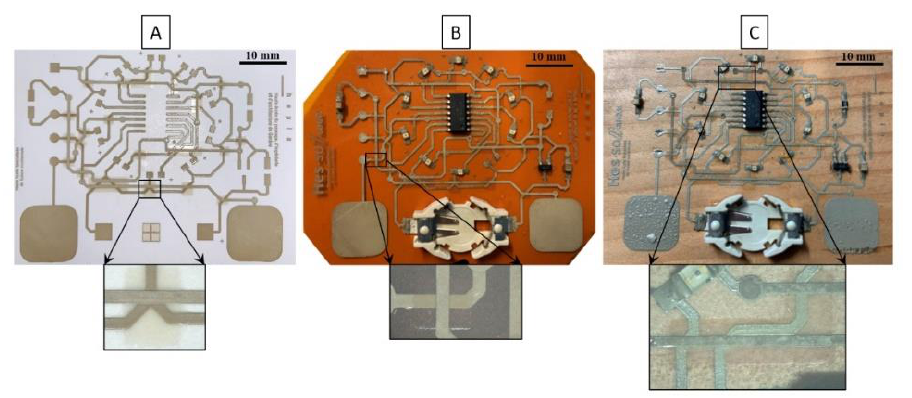
Figure 8. Photographic views of a multilayer demonstrator pad-printed on: ( A ) Cardboard, ( B ) Kap- ton, ( C ) Wooden board.